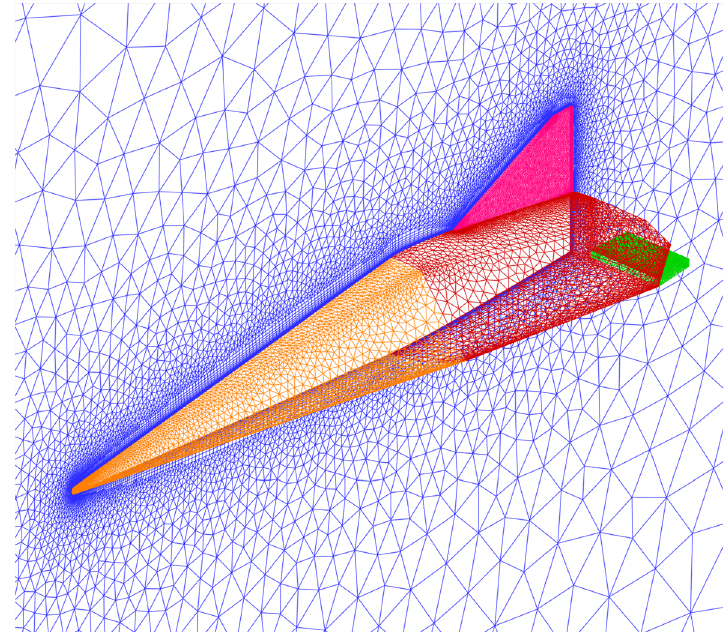
Fig. 5 Sketch of the computational mesh for the FDL‑5A configuration